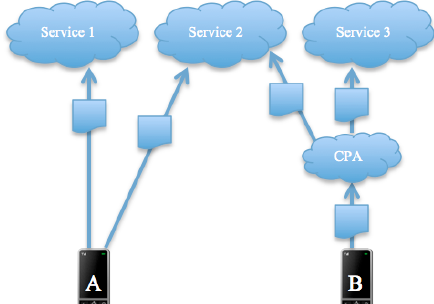
Figure 2. Rather than wasting resources uploading a file twice to two different services individually